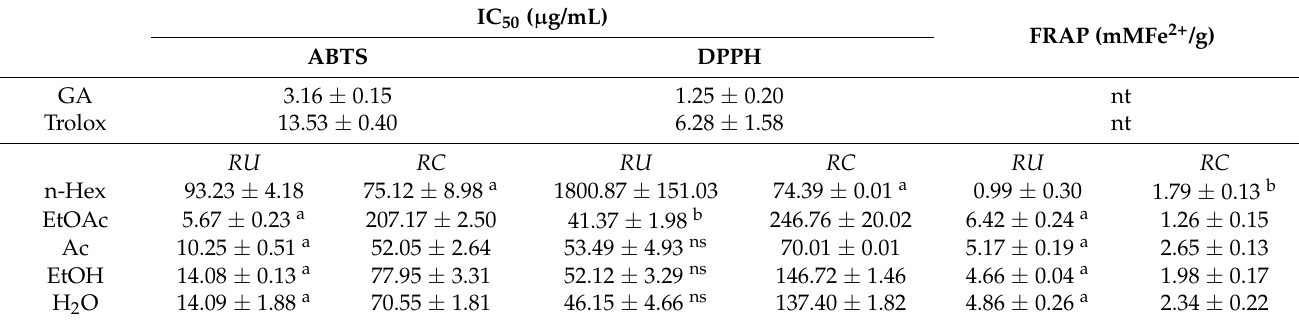
Table 3. Antioxidant and free radical scavenging activities of RU and RC